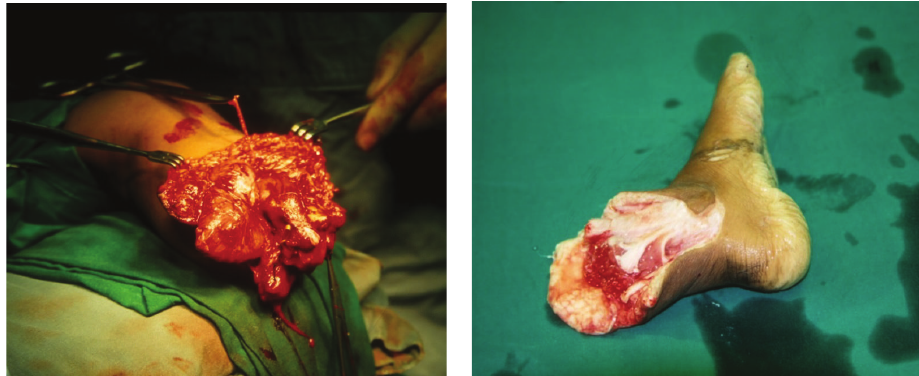
Figure 1: Preoperative.